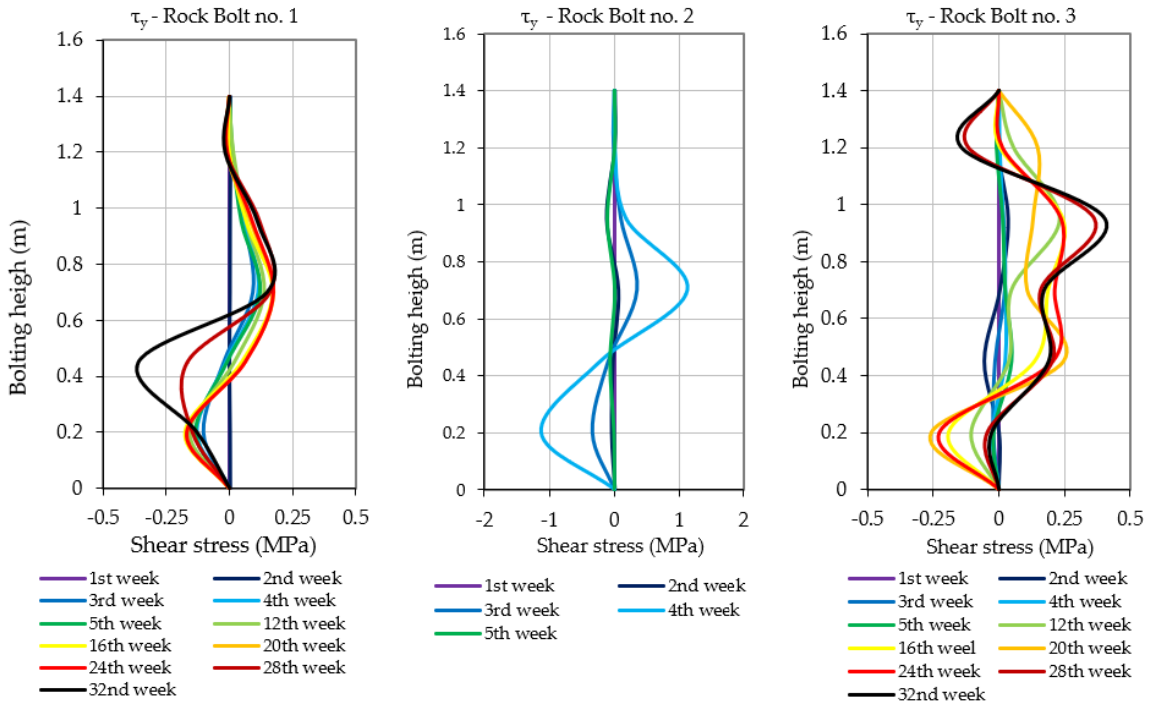
Figure 14. Shear stresses measured in rock bolts ’ bars during the underground measurements.